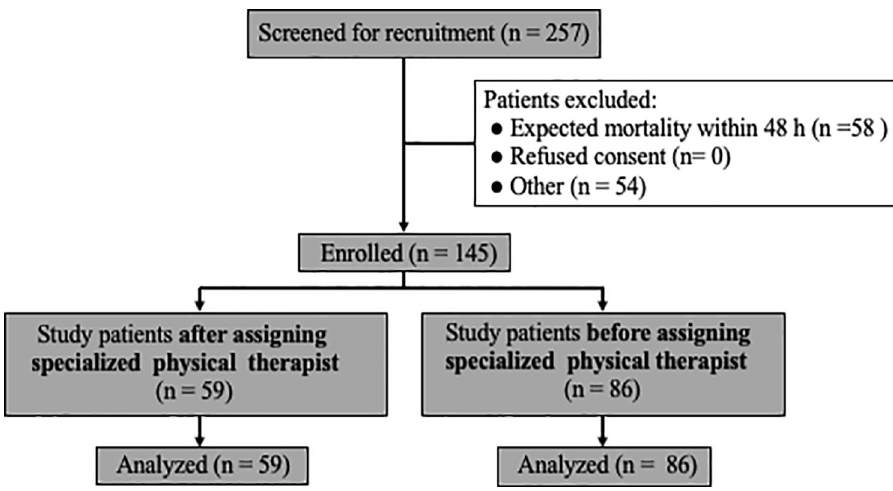
Fig 1. Flow chart of study participation. Two hundred fifty-seven subjects were in the initial patient pool. After exclusion criteria were applied, 145 subjects were included in the analysis.